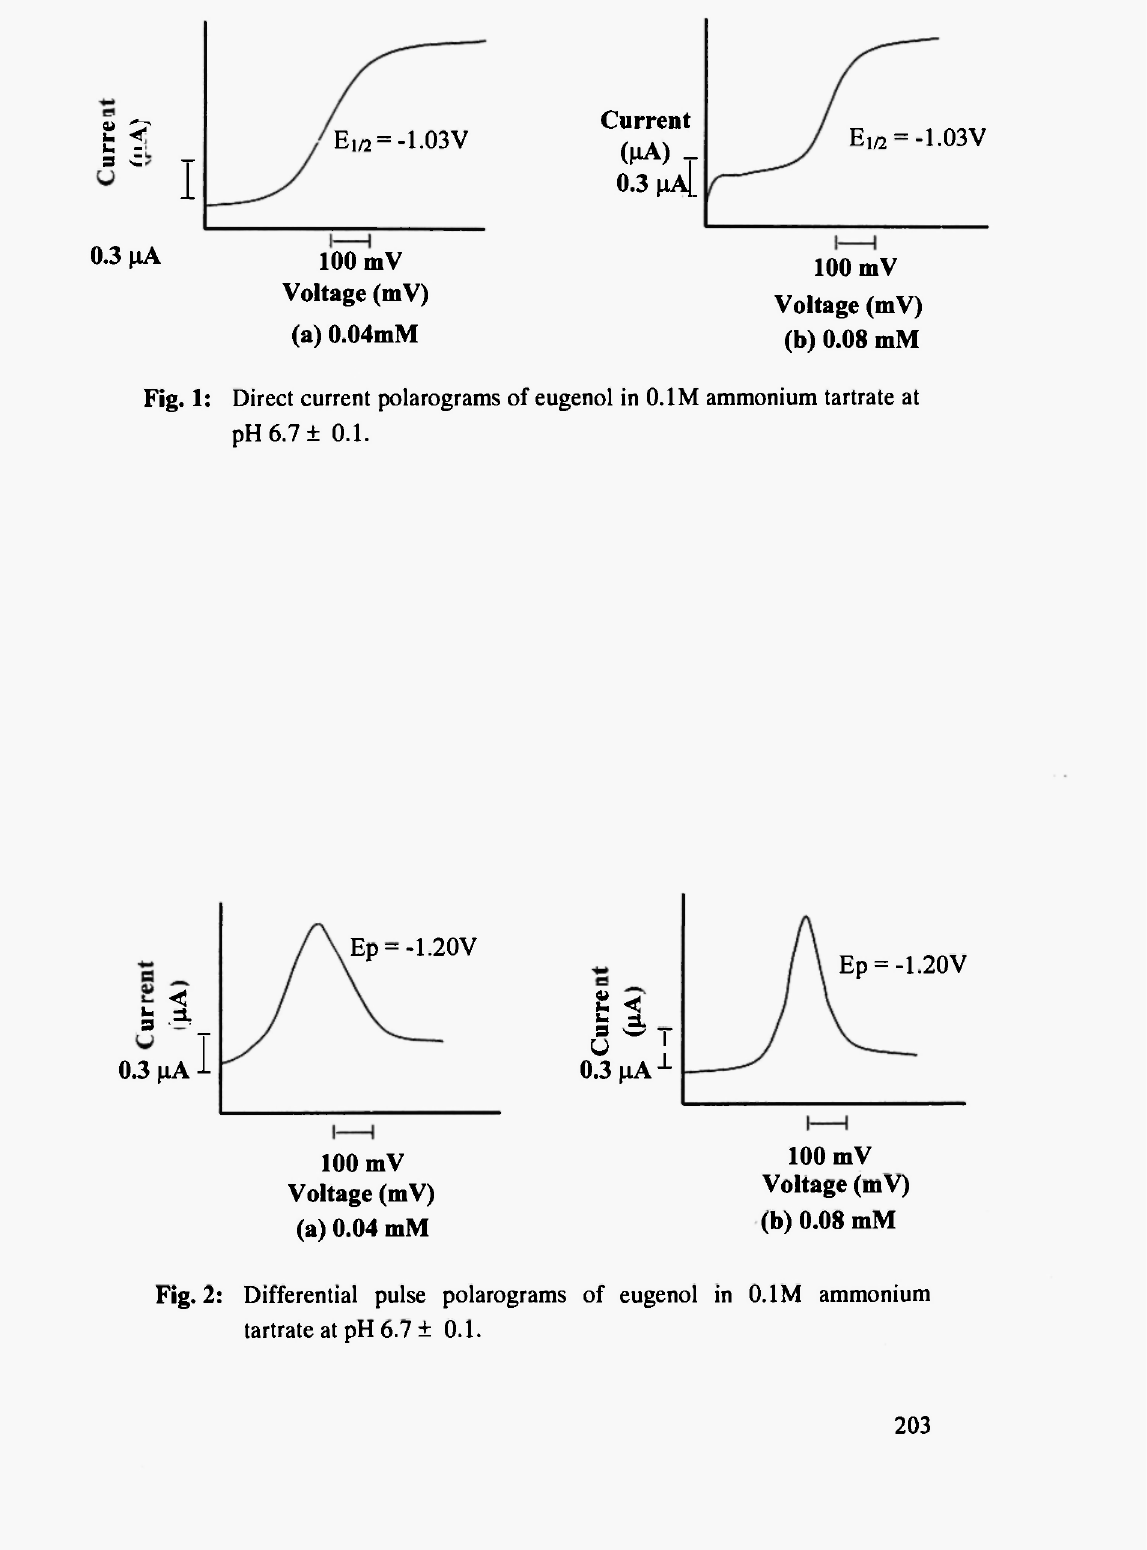
Fig. 1: Direct current polarograms of eugenol in 0.1 Μ ammonium tartrate at pH 6.7 ± 0.1.